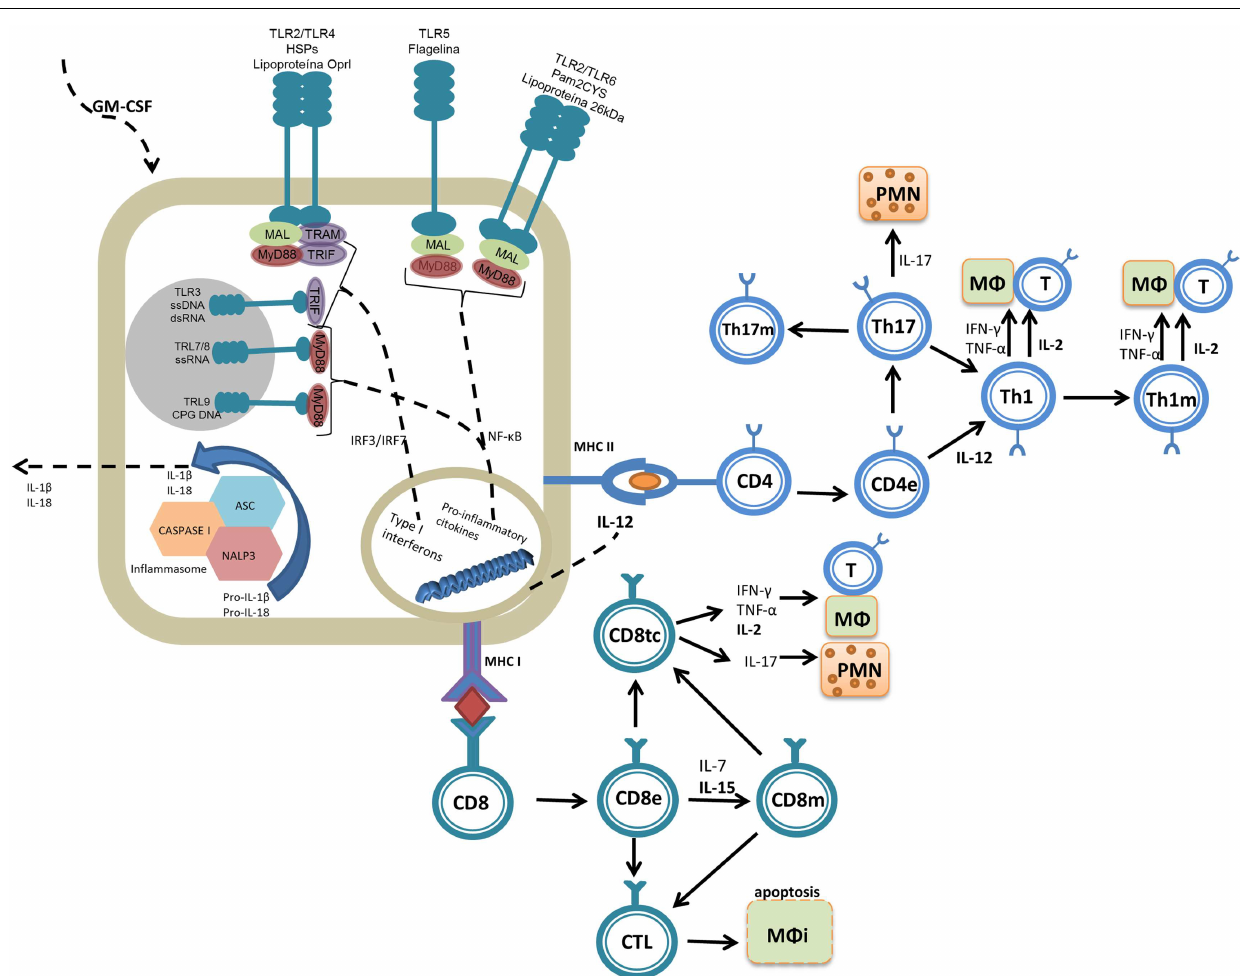
FIGURE 1 | Molecular mechanisms of the adjuvant molecules reviewed. Adjuvants are molecules that promote inflammatory reactions, interacting with the innate immune system and assisting in the generation of adaptive immune responses. PAMPs interact primarily withTLR2 (lipoproteins and Pam2Cys) andTLR5 (flagellin). DAMPs (e.g., Hsp70) can be recognized by many molecules of the immune system, but the innate immune system interacts with Hsp70 primarily throughTLR4. Adjuvants lead to the generation of intracellular signaling cascades (dependent on MyD88 andTRIF) that culminate with the production of pro-inflammatory cytokines.The cytokines then act as the third signal, aiding the development of the adaptive immune response in combination with the presentation of the fused antigen (first signal). Effector (e) and memory (m)